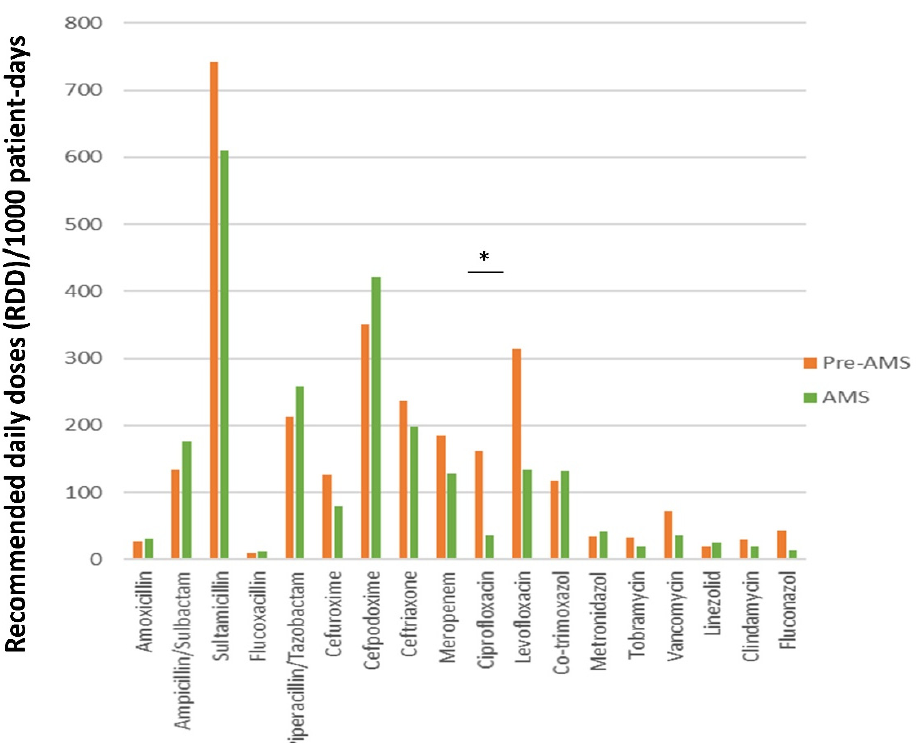
Figure 2. Changes in antimicrobial prescription patterns during the antimicrobial stewardship pro- gram; green bars: pre-antimicrobial stewardship; yellow bars: antimicrobial stewardship; * p < 0.05, AMS: antimicrobial stewardship.